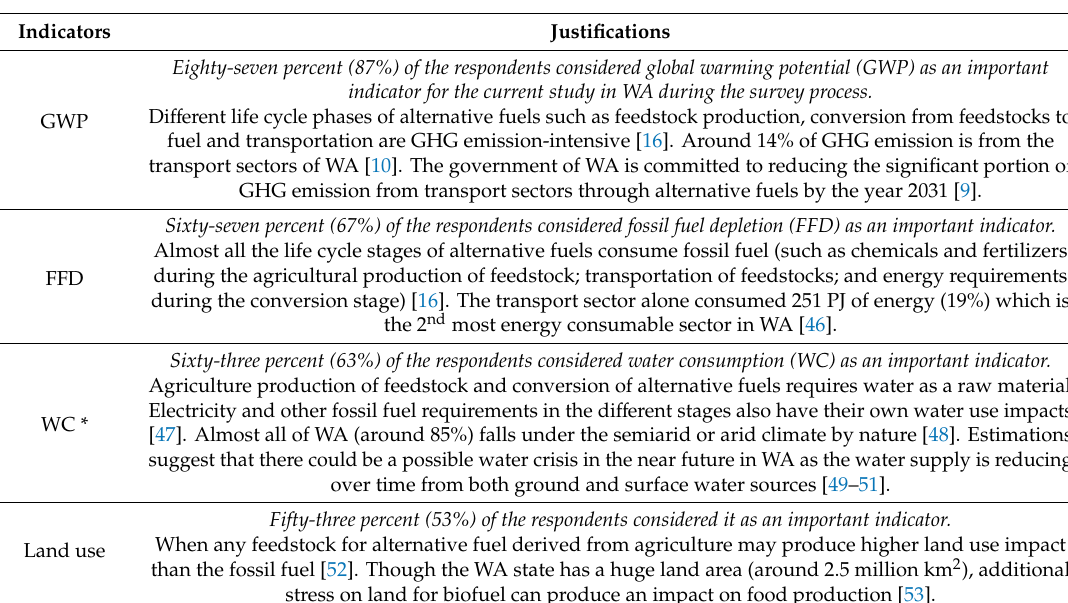
Table 3. Justifications for included / excluded